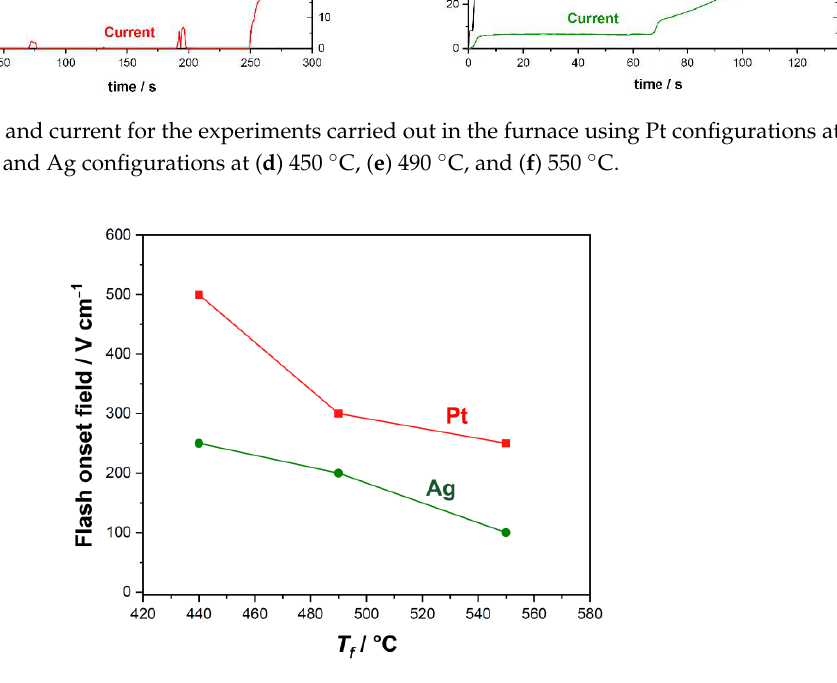
Figure 4. The logarithm of conductivity as a function of the estimated sample temperature for ( a ) Pt-plated and ( b ) Ag- plated samples.